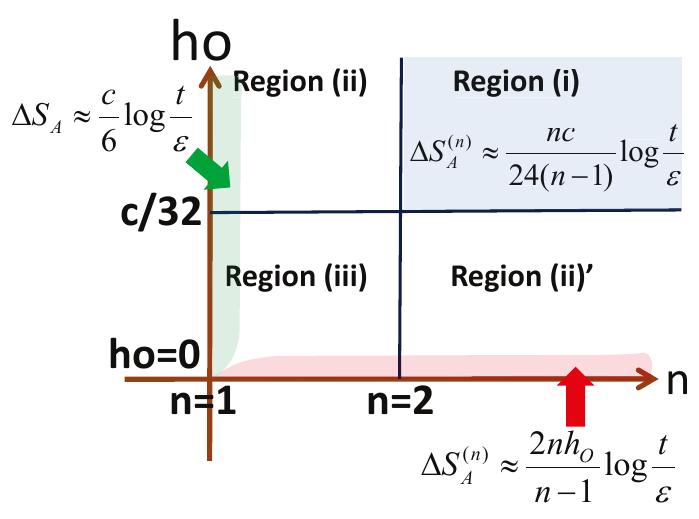
Figure 1 . We summarized the behaviors of the logarithmic growth of Renyi entanglement entropy n ) ∆ S ( A ( t ). The green and red regions can be well approximated by the HHLL conformal block